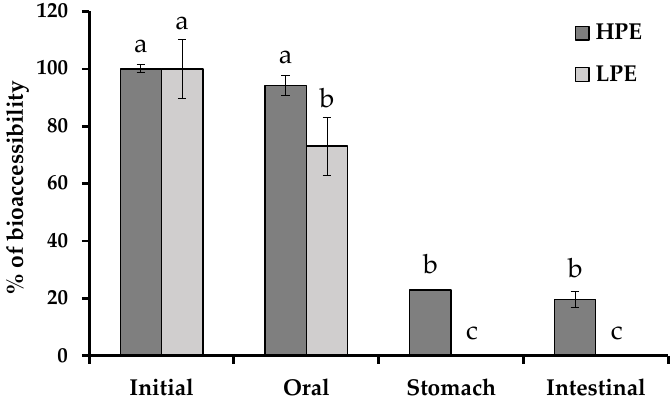
Figure 2. Bioaccessibility of the polymeric phenolic compounds of HPE during the simulated digestion process. Data represent mean ± SD ( n = 9). a,b,c Different letters indicate significant differences between digestion steps in a group using the LSD test ( p < 0.05).